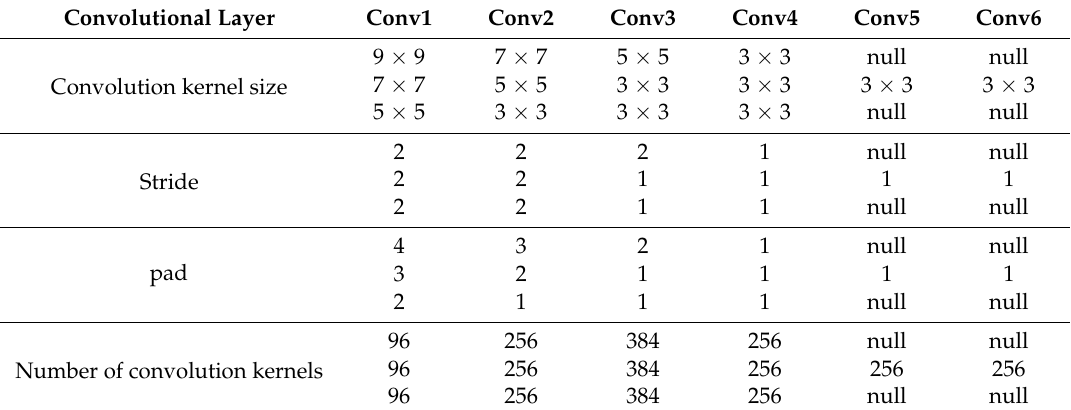
Table 3. Basic parameters of Multi-PerNet3.